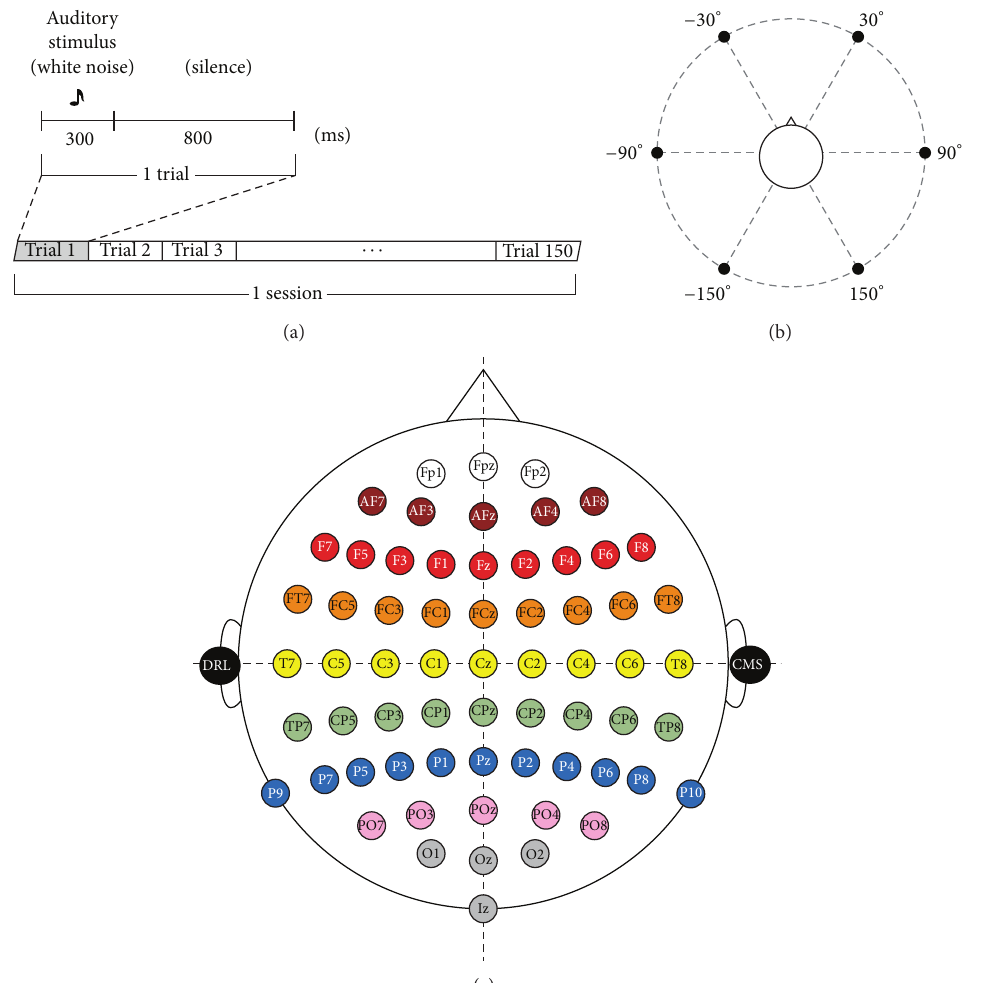
Figure 2: (a) Experimental protocol used to measure the auditory P300 signals. (b) Direction of the virtual sound sources. (c) 64 EEG channel layout used in the experiments. DRL and CMS are the references attached to the